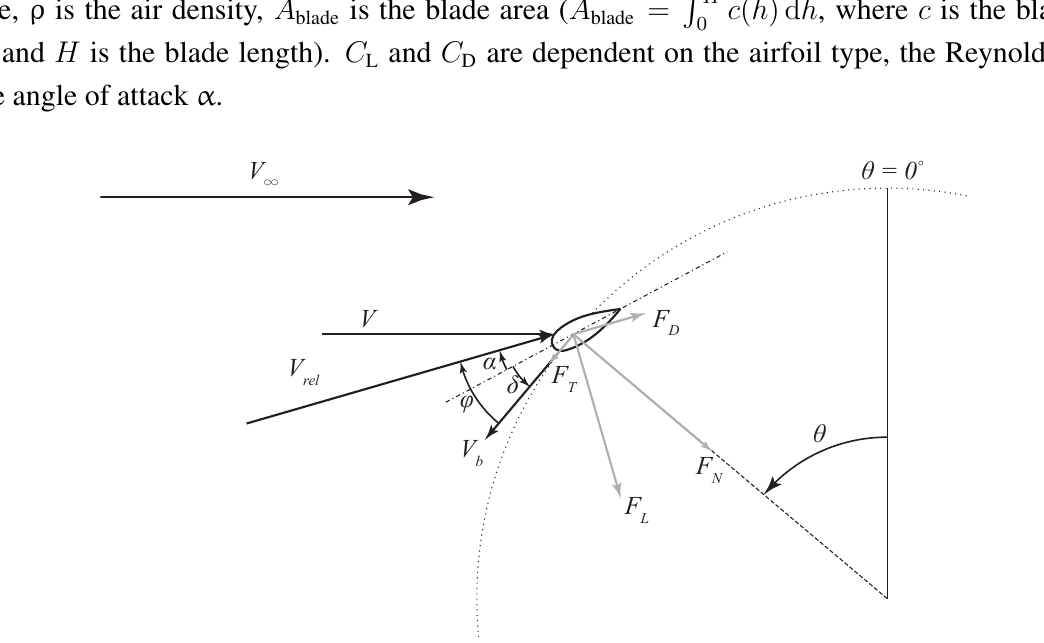
Figure 1. Definitions of the force and velocity vectors for vertical axis wind turbines (VAWTs). Angle θ is the blade azimuthal angle. The counter-clockwise direction is positive for the angles. Note that the angles α and ϕ are negative for the directions of V in the figure. The positive direction of F figure is